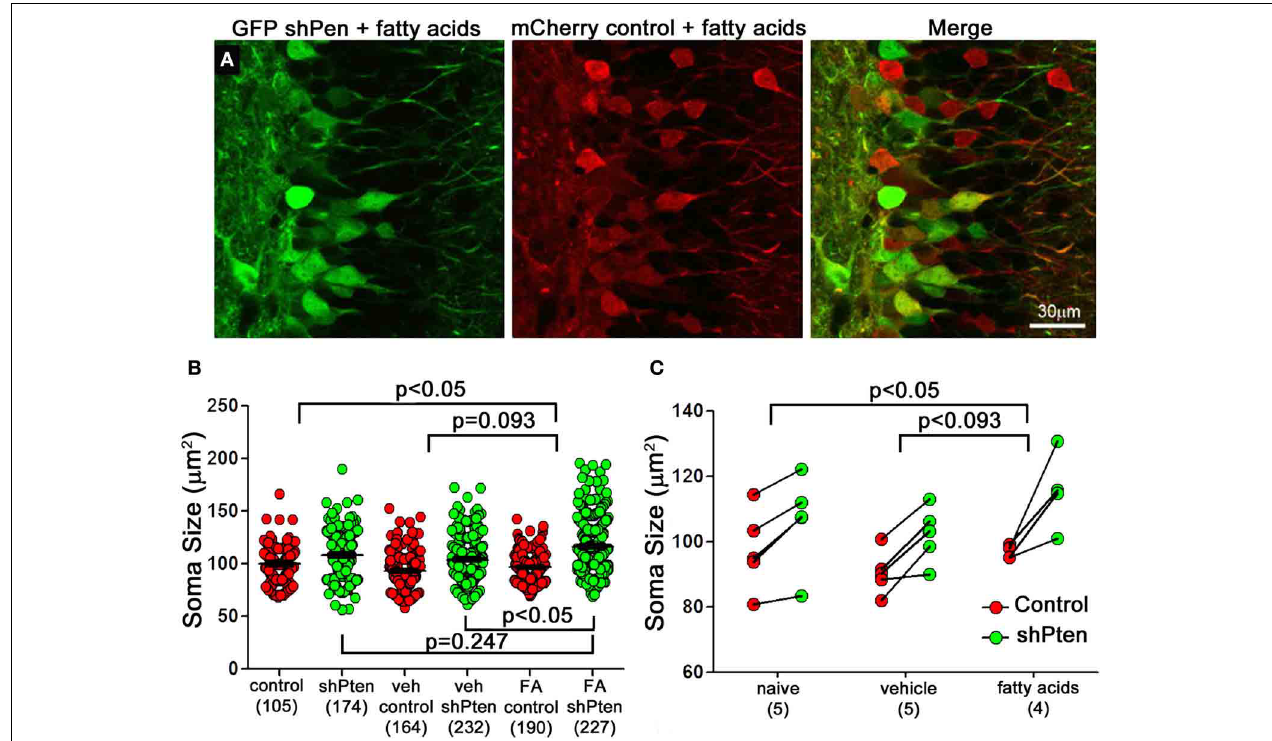
n = 190 and 227 neurons from 4 animals) and fatty acid treatment exacerbated this effect (veh shPten vs. FA shPten, p < 0 . 05). (C) Displaying the data grouped by animal demonstrates an increase in soma size of the fatty acid treated neurons compared to wild type (naïve control = 100 ± 1 . 75 µ m 2 , naïve shPten = 108 . 1 ± 1 . 66 µ m 2 vs.